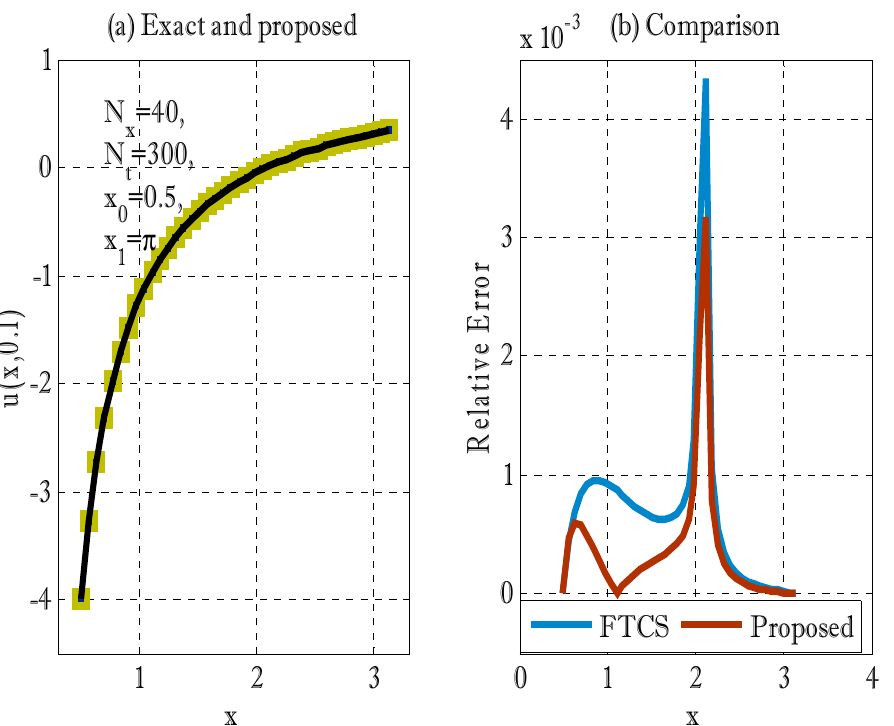
Figure 1. Comparison of the proposed scheme with FTCS. ( a ) exact and numerical solutions ( b ) FTCS and proposed